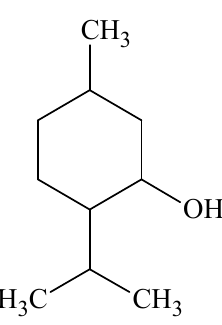
Figure 5. Mechanism by which terpenes act on the lipid bilayer of the stratum corneum (with permission from